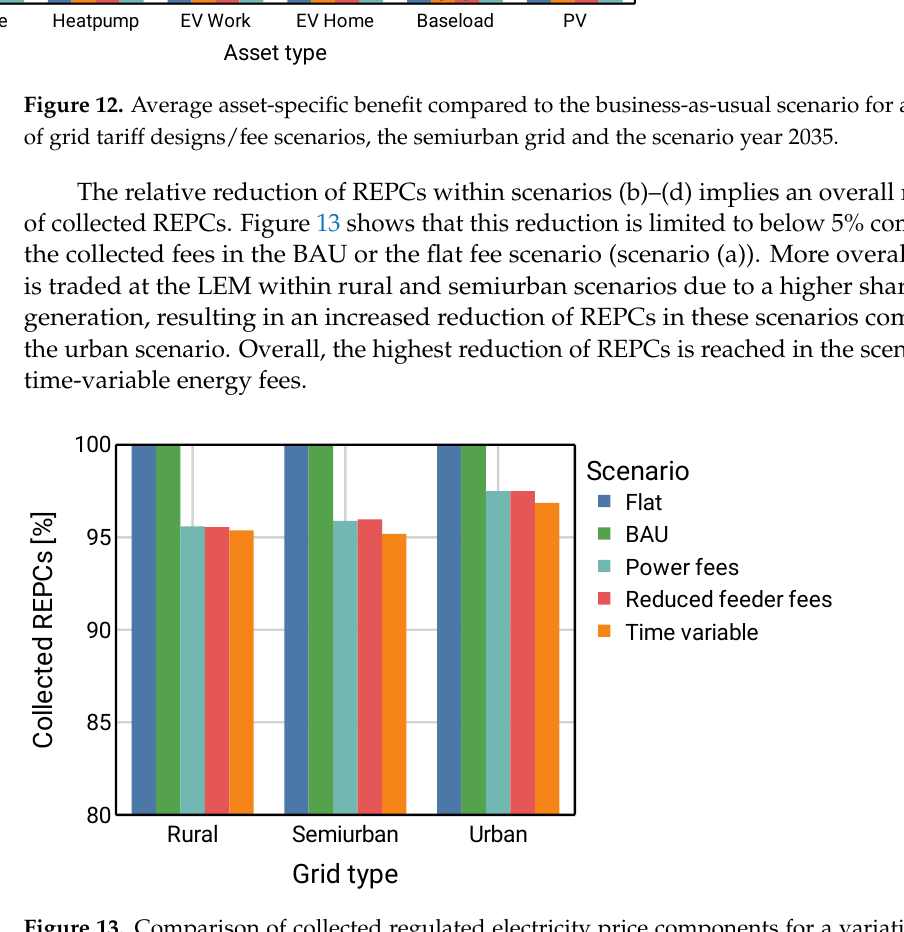
Figure 13. Comparison of collected regulated electricity price components for a variation of grid tariff scenarios for the scenario year 2035.